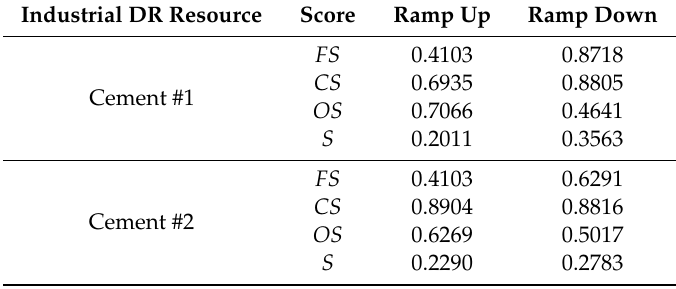
Table 1. Potential score result (season: summer; industrial DR resources: cement #1 and cement #2). Industrial DR Resource Score Ramp Up